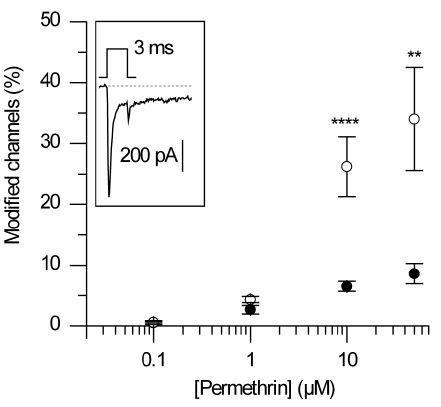
Figure 5. Dose-response curve of permethrin-modified sodium channels in ALNs. Percentage of permethrin-modified channels, calculated according to Eqn 3, from the permethrin-induced tail current amplitude measured 3ms after a single pulse (of 3 ms in duration, see inset). The percentage of modified channels increases as a function of permethrin concentration (filled circle, n=7, 10, 25 and 9 at 0.1, 1, 10 and 50 m M respectively). The same curve but recorded in ORNs (from Kadala et al. 2011) is shown for comparison (empty circles, n=3, 9, 14, 5).